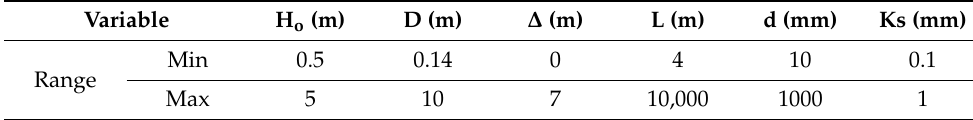
Table 3. Range of variability of examined hydraulic